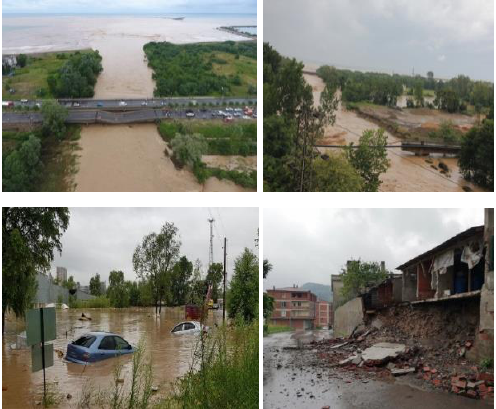
Figure 2. Examples to the damages after Aug 8 th , 2018 flood in Ordu (photo credits: TRT News,